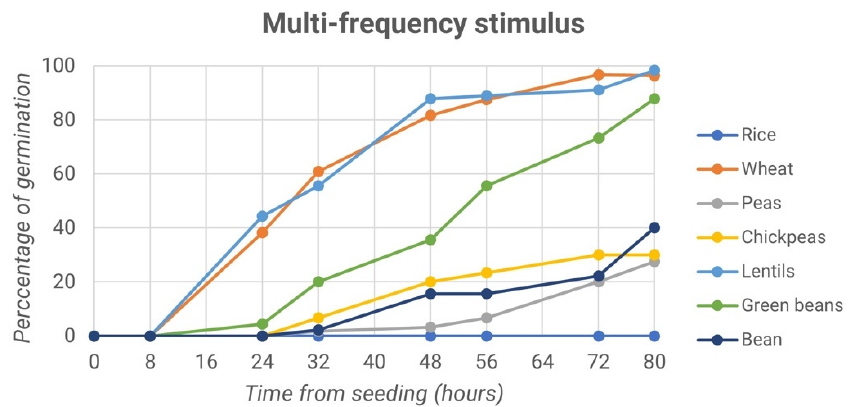
Figure 6. Percentage of germination vs. time from seeding: first experiment, multi-frequency stimulus.